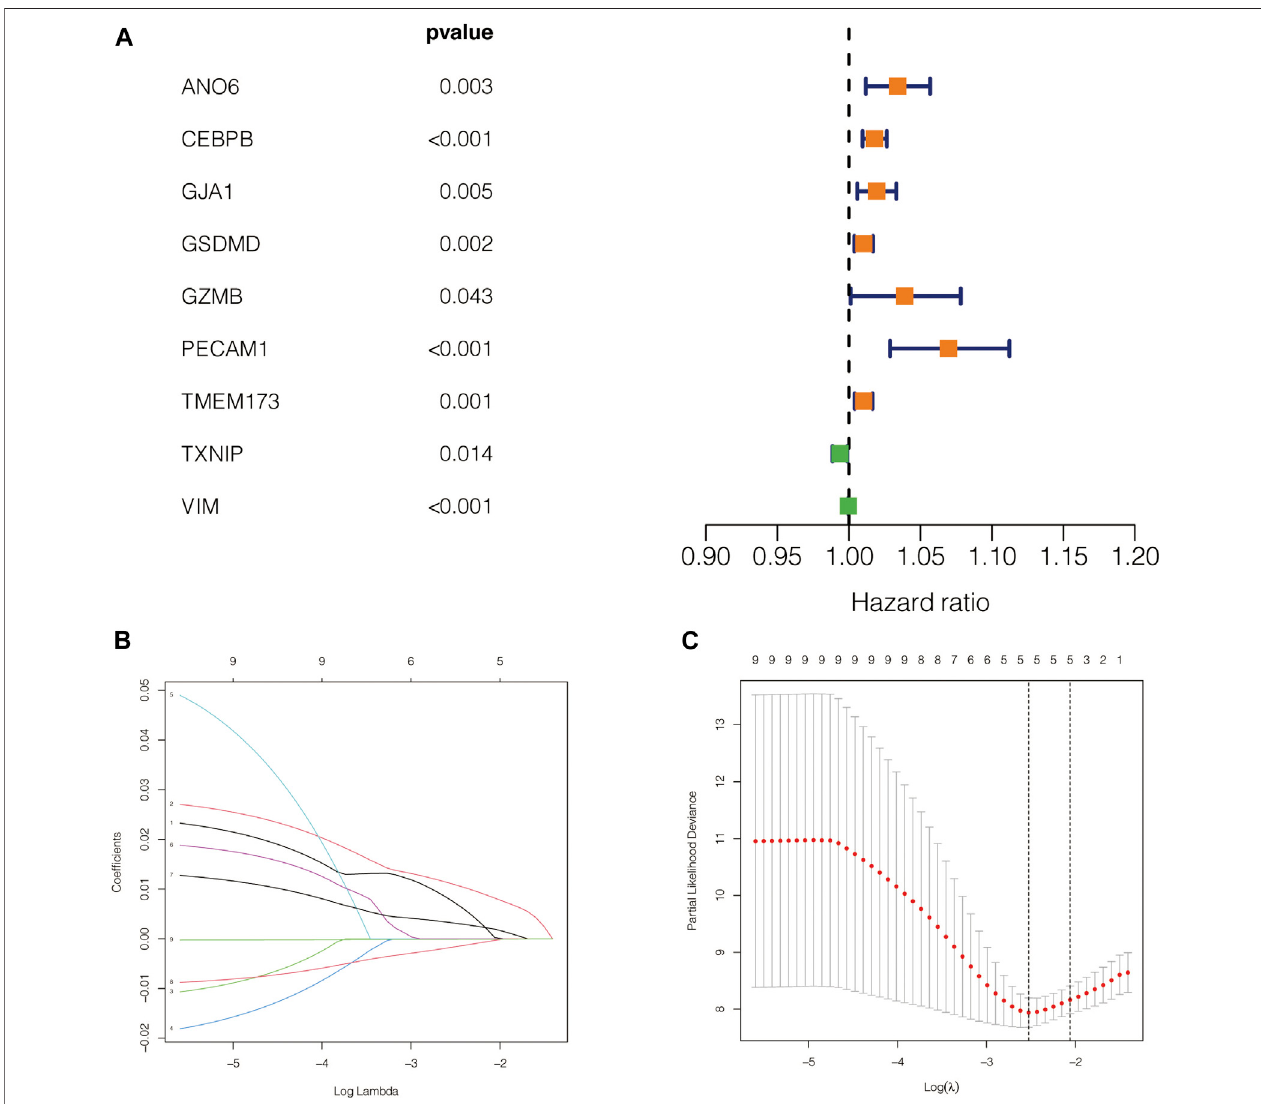
FIGURE 2 | Construction of the prognostic model. (A) The forestplot which contained the Hazard Ratio (HR) and its 95% con fi dence interval. (B,C) The potential prognostic genes were subsequently subjected to LASSO-Cox regression in the training cohort to generate a Prognostic signature.